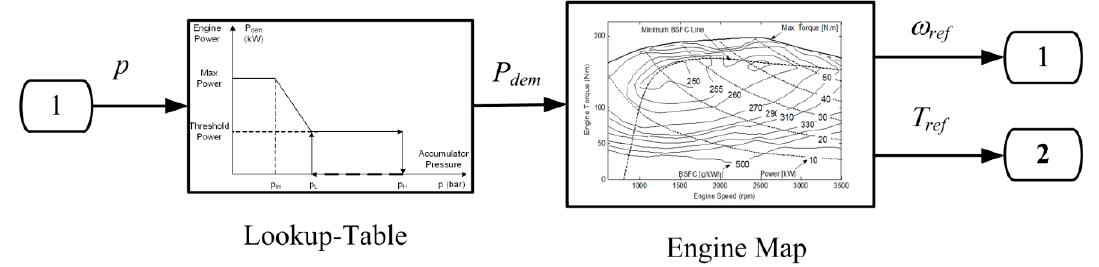
Figure 5. Schematic of Thermostatic Control Scheme.